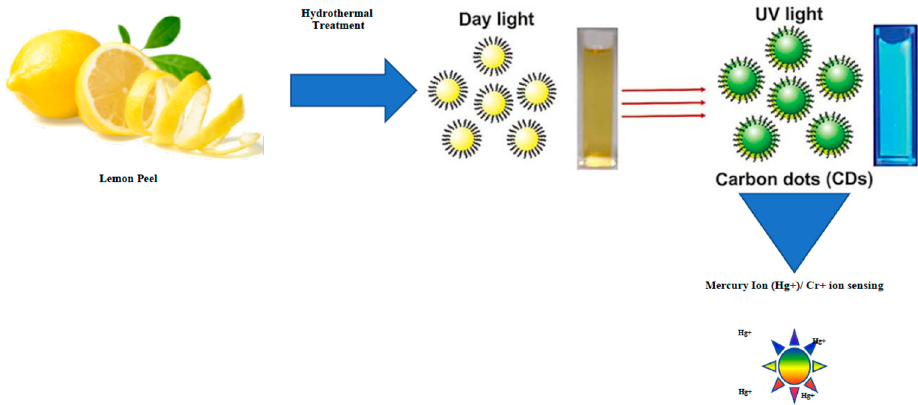
Figure 5. Schematic for the generation of water-soluble CQDs by hydrothermal treatment of lemon peel waste and their application in Hg + /Cr +